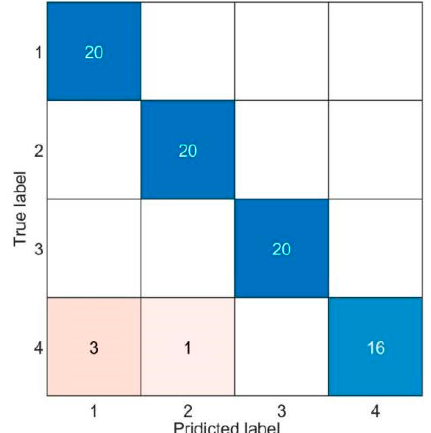
Figure 12. The confusion matrix of the VMD-SOA-SVM